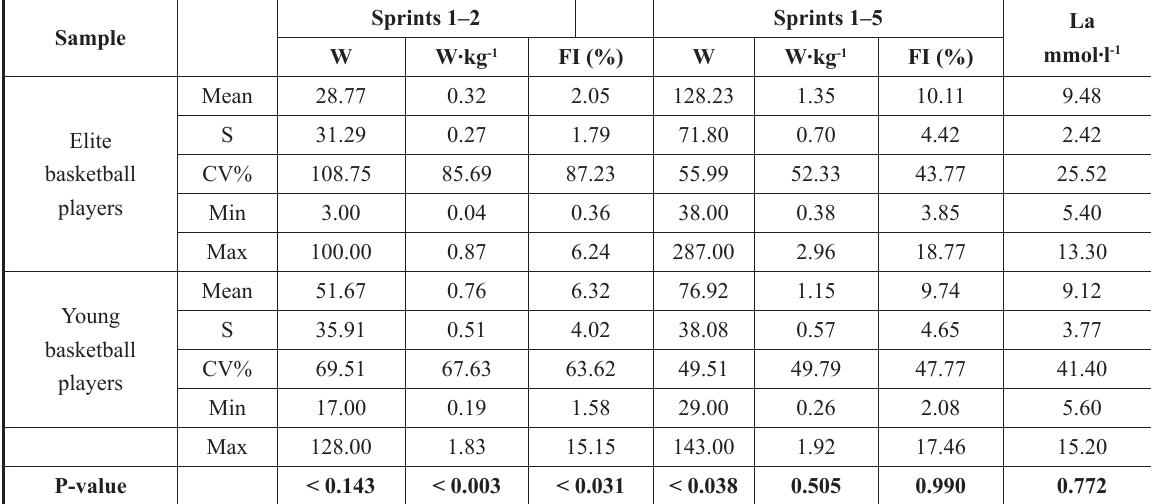
Table 2. Muscle power decrement of elite basketball players and young players between work interval 1 and 2 as well as between 1 and 5, as well as concentration of lactate in the